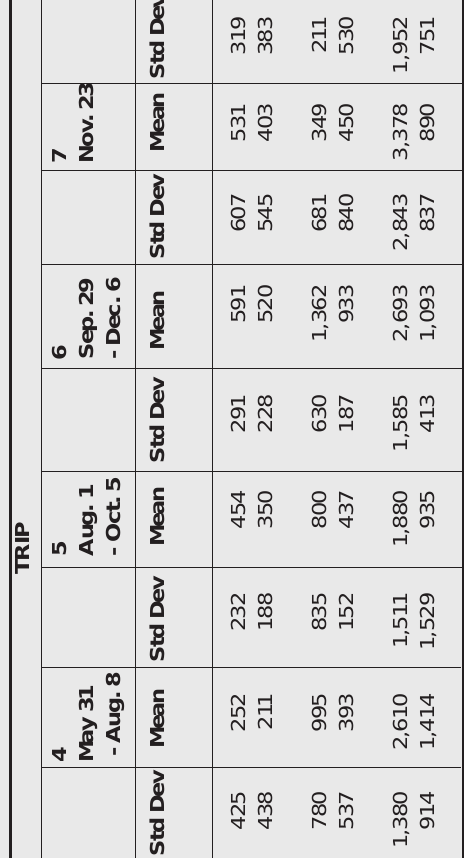
Fig. 7 Total P. decipiens abundance in pups (males +, solid line; females *, dashed line), juveniles and adult grey seals sam- pled during 1983 and 1989. The fitted lines were predicted from analysis of de- viance models.